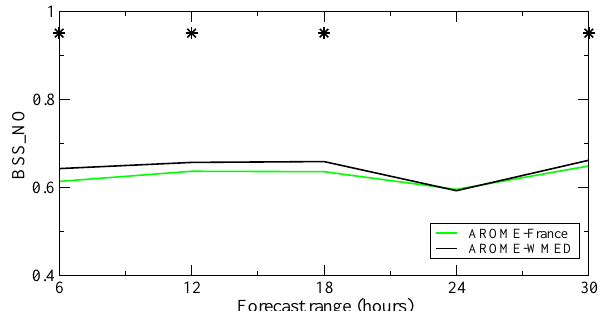
Figure 18. Brier skill score for simulated 10.8µm SEVIRI bright- ness temperature lower than 240K as a function of forecast range for SOP2 period (01 February 2013–15 March 2013). Stars indicate where the statistical significance of the difference between the two models exceeds 90%.